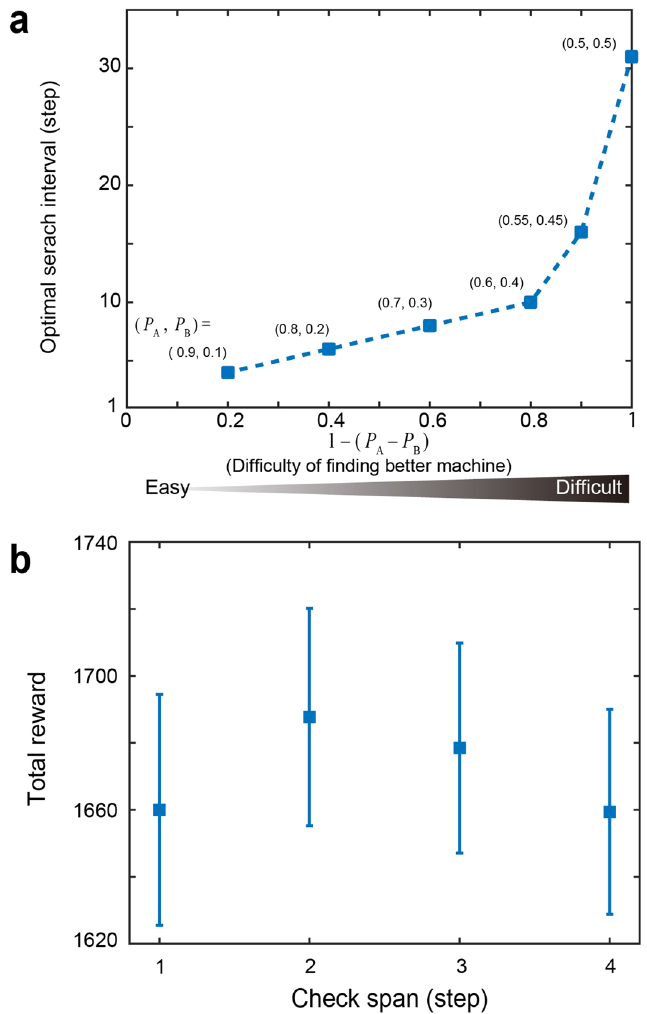
Figure 4. Optimal mixture of entangled- and correlated-photon-based decision making. ( a ) The optimal search interval monotonically increases as the difficulty of finding better slot machine increases. Also, if the difficulty is less than 0.8, a search interval of approximately 5–10 yields nearly optimal total rewards (see Fig. 3b). ( b ) The check span (CP) is another parameter for the mixed strategy. CP of 2 yields the maximum average total rewards. However, concerning the standard deviation denoted by the error bars, the achievable rewards are comparable, indicating that CP is not necessarily a dominant